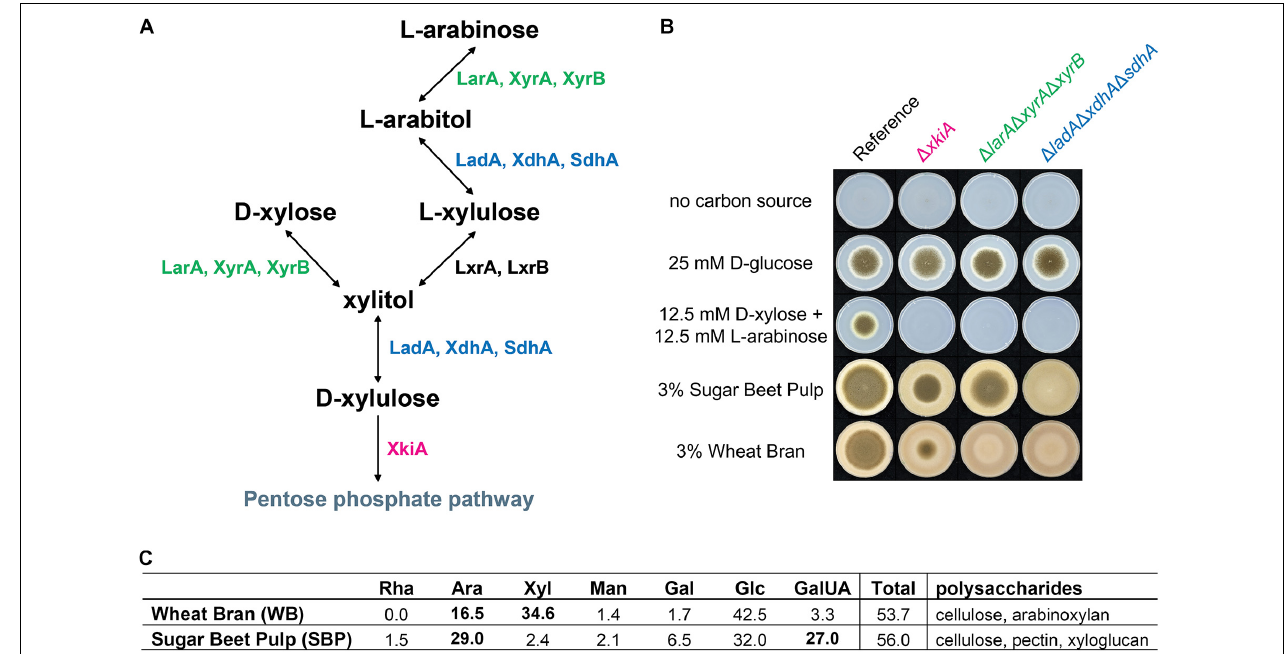
FIGURE 1 | (A) Pentose catabolic pathway (PCP) in Aspergillus niger . LarA = L -arabinose reductase, LadA = L -arabitol dehydrogenase, LxrA and LxrB = L-xylulose reductases, SdhA = sorbitol dehydrogenase, XyrA and XyrB = D -xylose reductases, XdhA = xylitol dehydrogenase, XkiA = D -xylulose kinase. (B) Growth profile of the A. niger reference strain (N593 (cid:49) kusA) and the PCP deletion mutants on solid MM with or without addition of carbon source. Strains were grown for 5 days at 30 ◦ C and (C) composition analysis of polymeric carbon sources, wheat bran (WB) and sugar beet pulp (SBP), used for growth profile and multi-omics analysis of PCP mutants. Rha = rhamnose, Ara = arabinose, Xyl = xylose, Man = mannose, Gal = galactose, Glc = glucose, GalUA = galacturonic acid. Concentration in